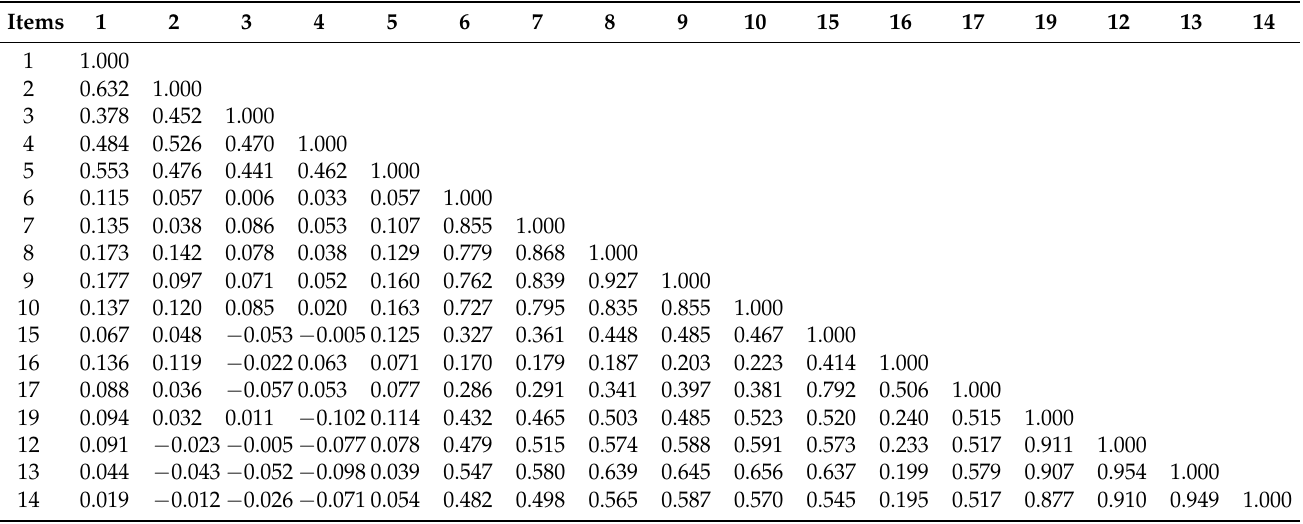
Table A1. Polychoric correlation matrix extracted from the